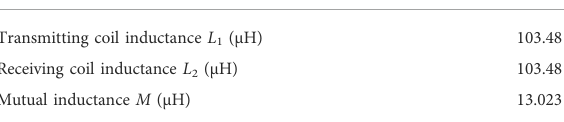
TABLE 1 Coupler parameters without foreign objects.